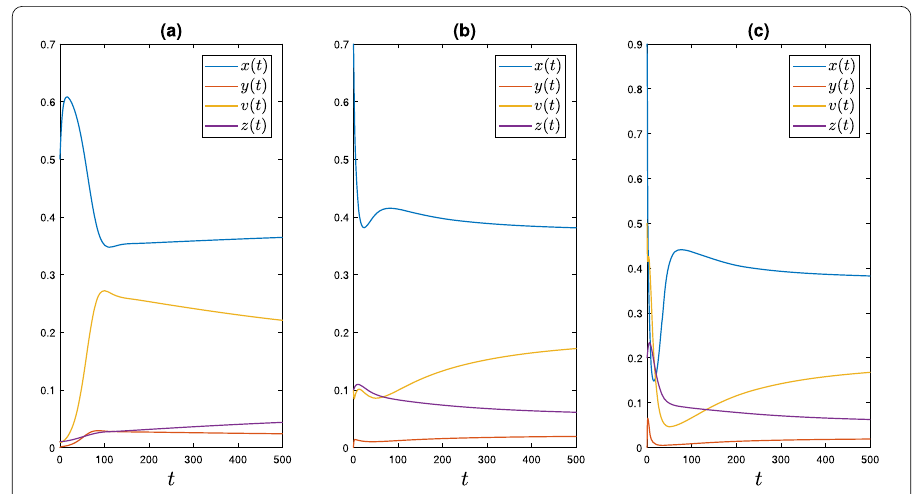
Figure 6 Numerical simulations of model (2) showing the time variation in the size of all relative populations of the model with various initial values. For these simulations, we used the following parameter values: r 1 = 0.36, a = 0.3, h 1 = 0.6, d 1 = 0.1278, c = 0.3, b = 2, h 2 = 0.16, e = 0.1, m 1 = 0.6, m 2 = 0.1, and n =